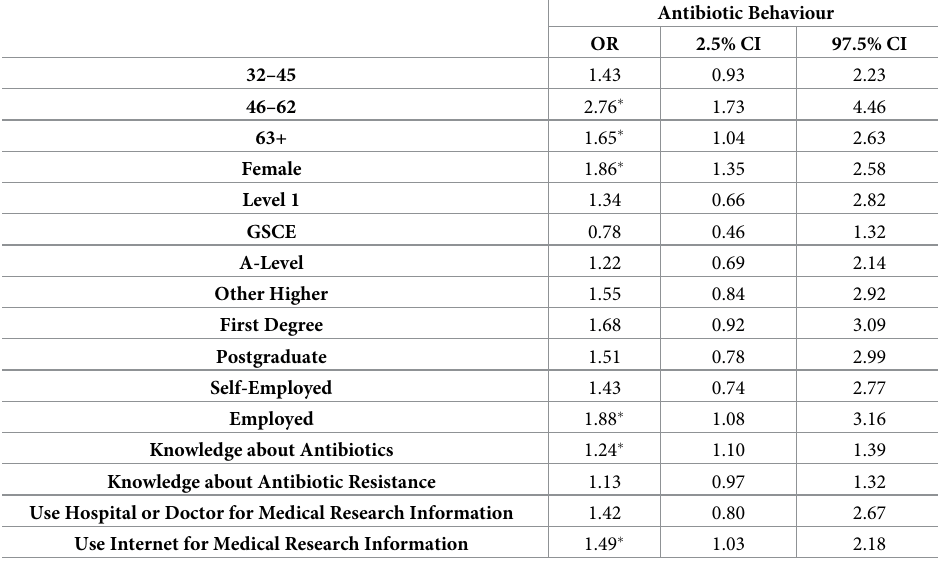
Table 4. Logistic regression analysis of monitor behaviour